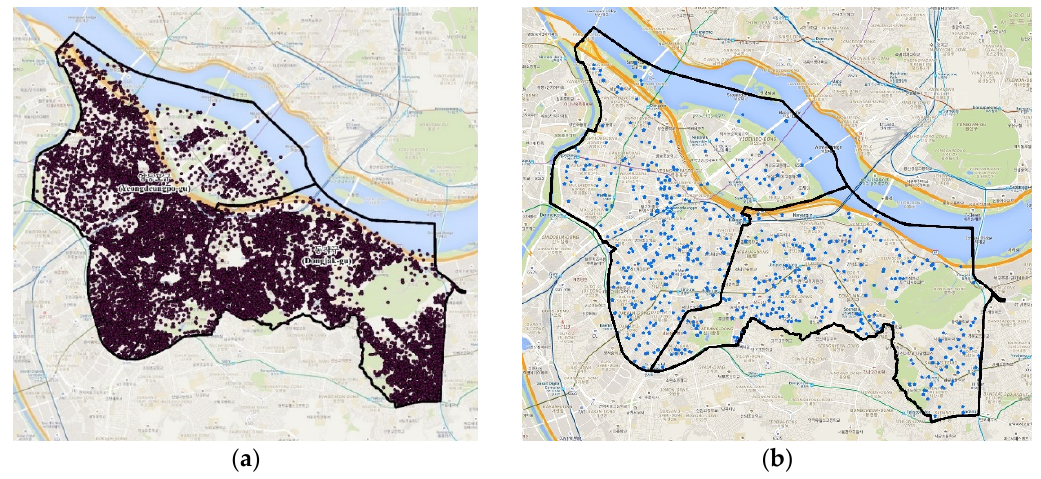
Figure 9. Incident records with appropriate information in the study area: ( a ) entire emergency call records and ( b ) OHCA records only.